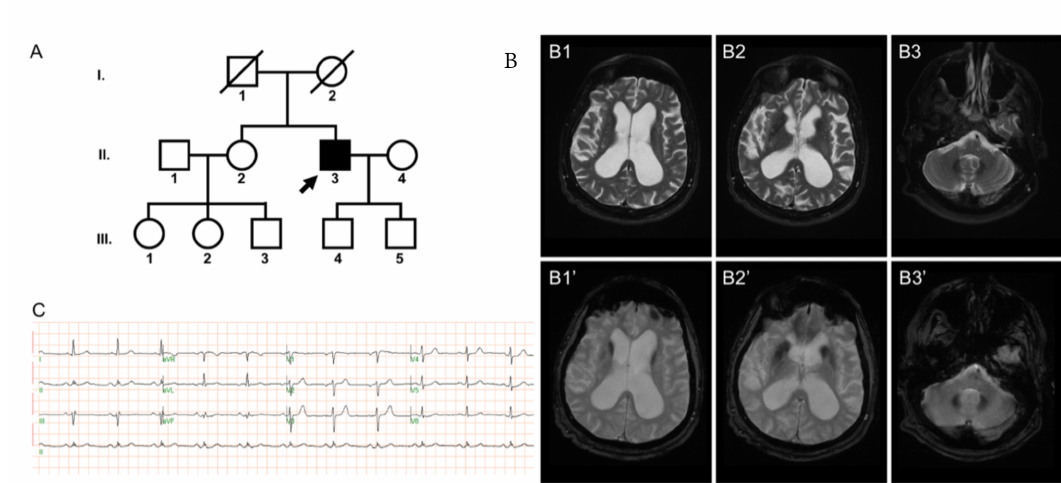
Figure 1. Clinical features of the patient with the KCND3 c.1256G>A (p.R419H) variant. ( A ) Pedigree of the patient characterized in current study. In this pedigree, the heterozygous KCND3 variant was detected in the male individual II.3, who is now 70 years old. The patient’s father (I.1) passed away in his seventies due to heart failure, and his mother (I.2) in her eighties due to chronic obstructive pulmonary disease. He has a sister (II.2) who is five years older than him. His two sons (III.4 and III.5) are now in their thirties. Arrow denotes the index case who harbors the KCND3 c.1256G>A (p.R419H) variant. Filled symbol represents symptomatic member. Open symbols indicate unaffected individuals. Circles stand for females. Squares correspond to males. Diagonal lines refer to the deceased. ( B ) Neuroimages of the patient. The axial T2-weighted ( B1 – B3 ) and the corresponding gradient-echo sequence ( B1 (cid:48) – B3 (cid:48) ) images demonstrate hypointensity in bilateral caudate nuclei ( B1 , B1 (cid:48) ) and lentiform nuclei ( B2 , B2 (cid:48) ) of the basal ganglia, as well as in bilateral dentate nuclei of the cerebellum ( B3 , B3 (cid:48) ). ( C ) Standard 12-lead ECG indicates normal sinus